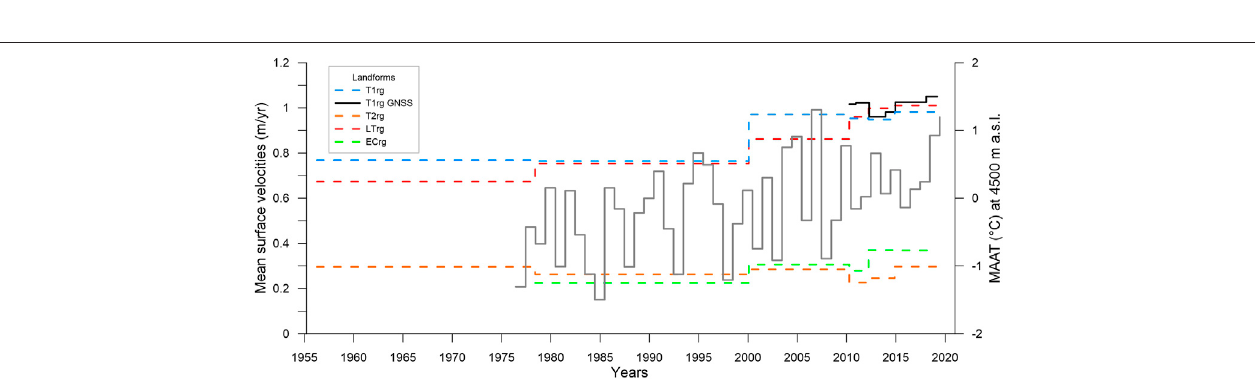
FIGURE 7 | Time series of mean surface velocities for the kinematics zones as de fi ned in Figure 5 . The continuous black line represents the Tapado 1 (T1rg) rock glaciermeansurface velocities obtained fromthe GNSS surveys (6points) between 2010and 2019.TheMAATat 4,500 ma.s.l. (continuousgreyline)wasextrapolated from La Laguna meteorological station (3,130 m a.s.l.) using a temperature lapse rate of -0.6 ° C per 100 m.